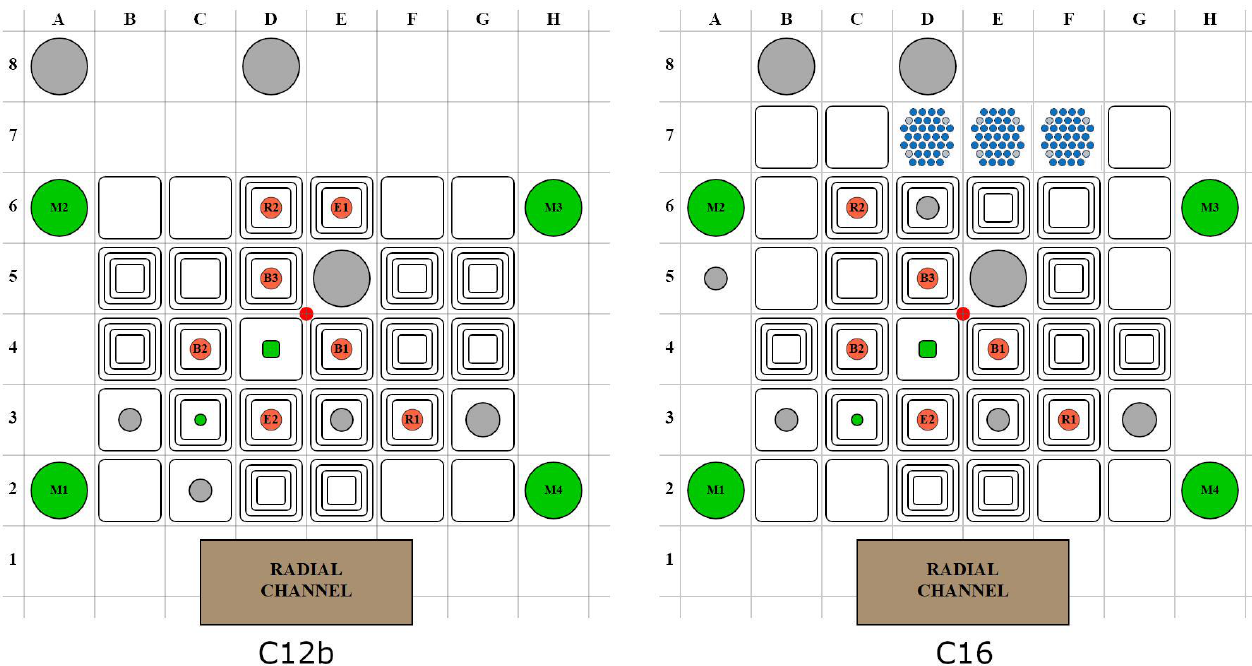
Fig. 7 Comparison of C12b and C16 core configurations. Stainless steel reflector is composed of three blue